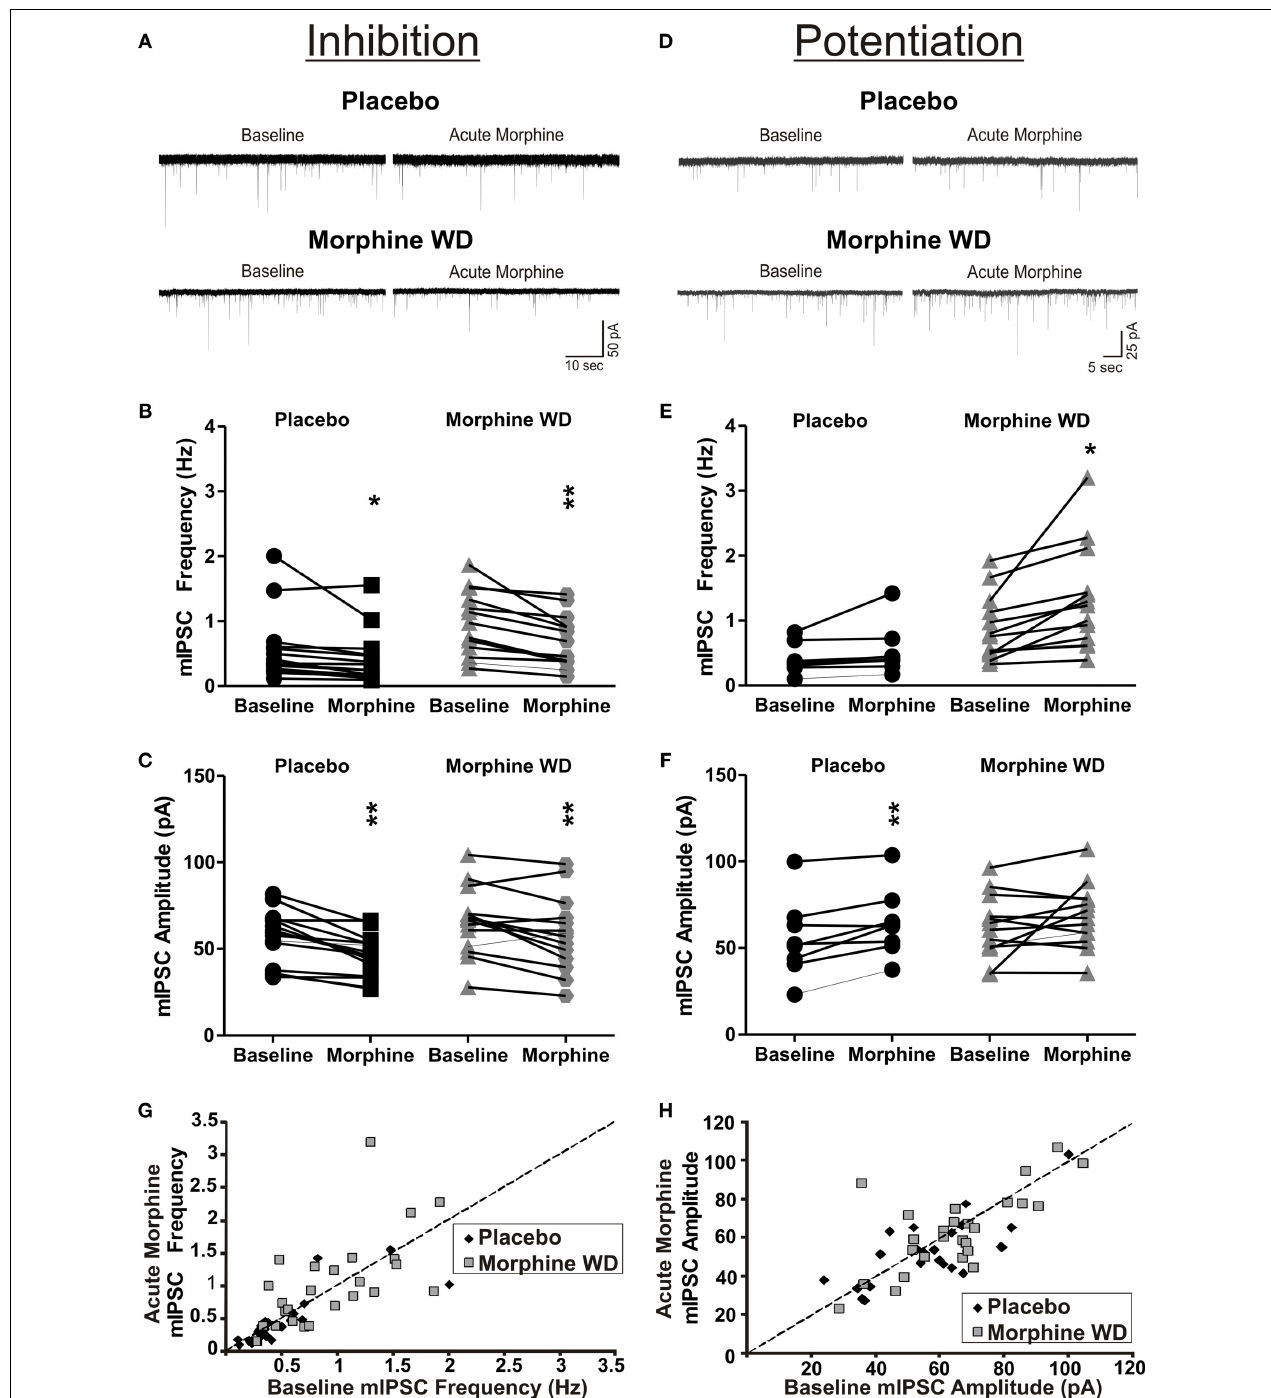
FIGURE 2 | Acute morphine has mixed effects on GABAergic transmission in the CeA following naloxone-precipitated withdrawal. (A) Representative recordings from the CeA neurons responding to acute morphine (10 μ M) application by an inhibition of mISPCs from placebo (top panel) and morphine withdrawn (bottom panel) rats. (B,C) In 64% of neurons from placebo and 45% from morphine-withdrawn rats, acute morphine decreased the frequency and amplitude of the mIPSCs. (D) Representative recordings of CeA neurons from placebo and morphine-withdrawn rats that